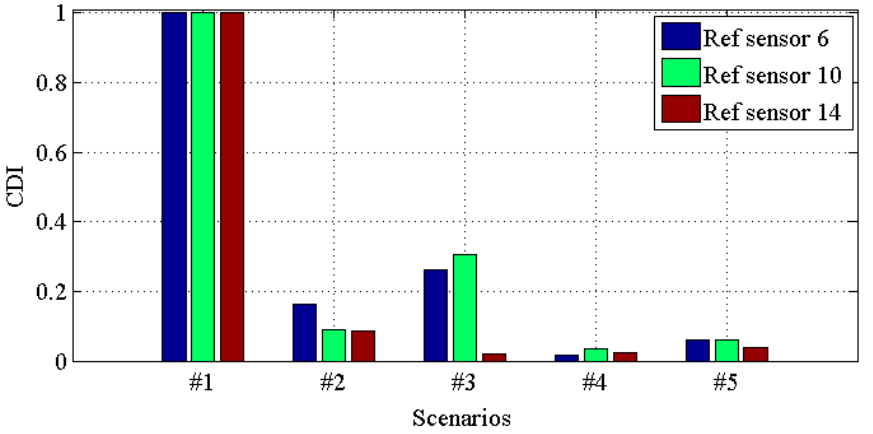
Figure 11. CDI for transmissibilities T(2, :), T(6, :), T(10, :) and T(14, :) with reference sensor 6, 10 and 14 for damage scenario #1 to #5.